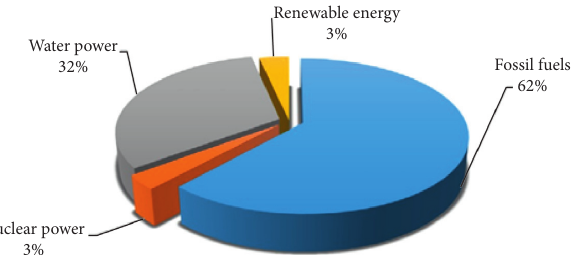
Figure 2: The production capacity per energy source [12,